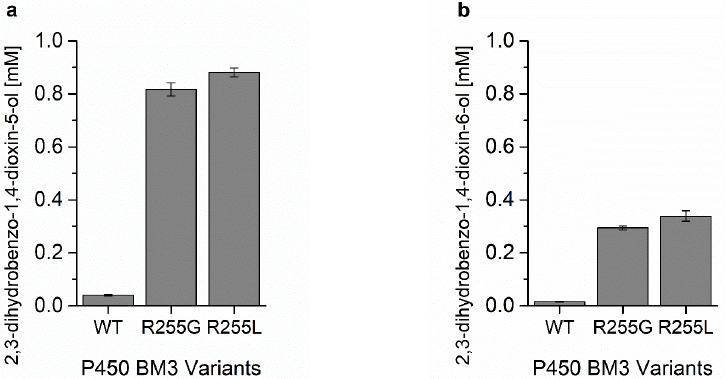
Figure 6. Product formation of different P450 BM3 variants measured with GC-FID. ( a ) 2,3-dihydrobenzo-1,4-dioxin-5-ol detected by GC-FID after 1 h of benzo-1,4-dioxane conversion. ( b ) 2,3- dihydrobenzo-1,4-dioxin-6-ol detected by GC-FID after 1 h of benzo-1,4-dioxane conversion.